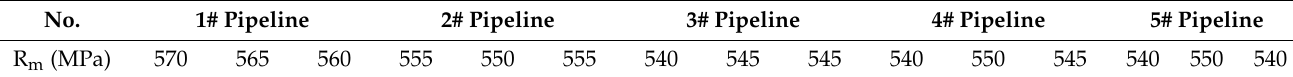
Table 3. Tensile strength of welding zone.